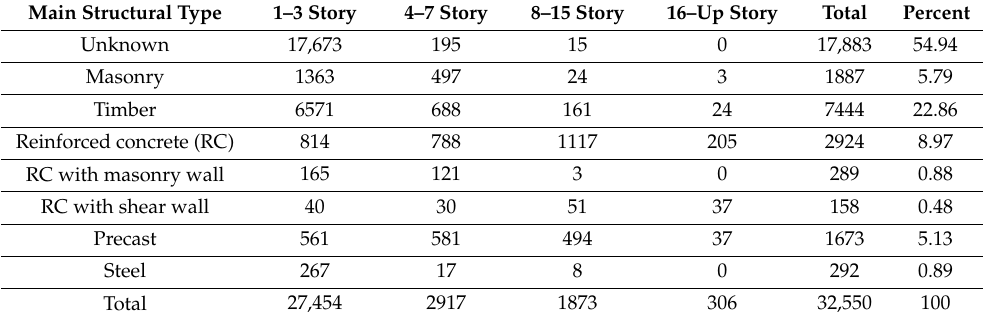
Table 2. The number of buildings with structural type and number of stories in existing inventory